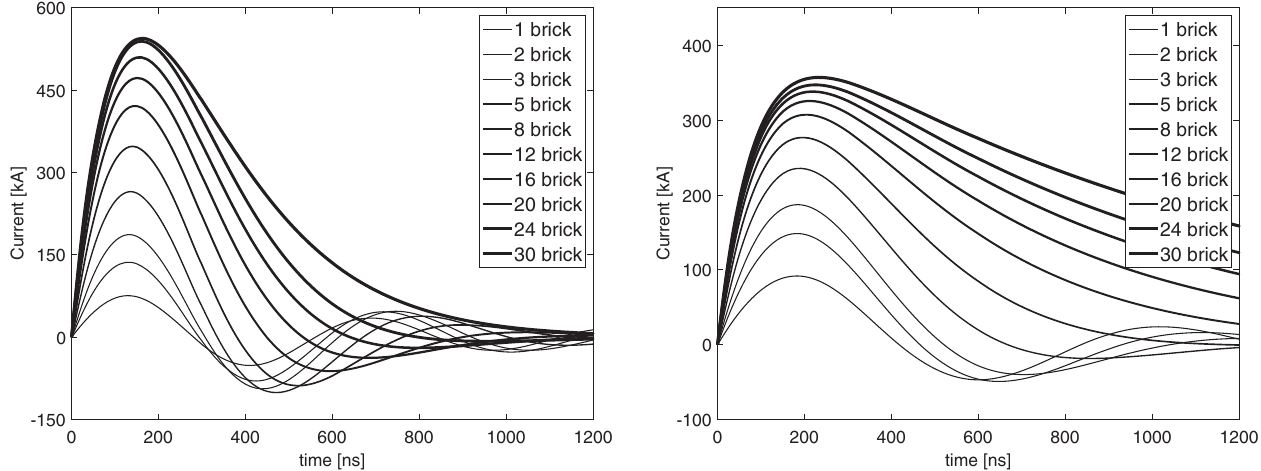
FIG. 10. Simulated output currents into an x-pinch load for a standard pulser (left) and a dry pulser (right), where the number of bricks is varied for each